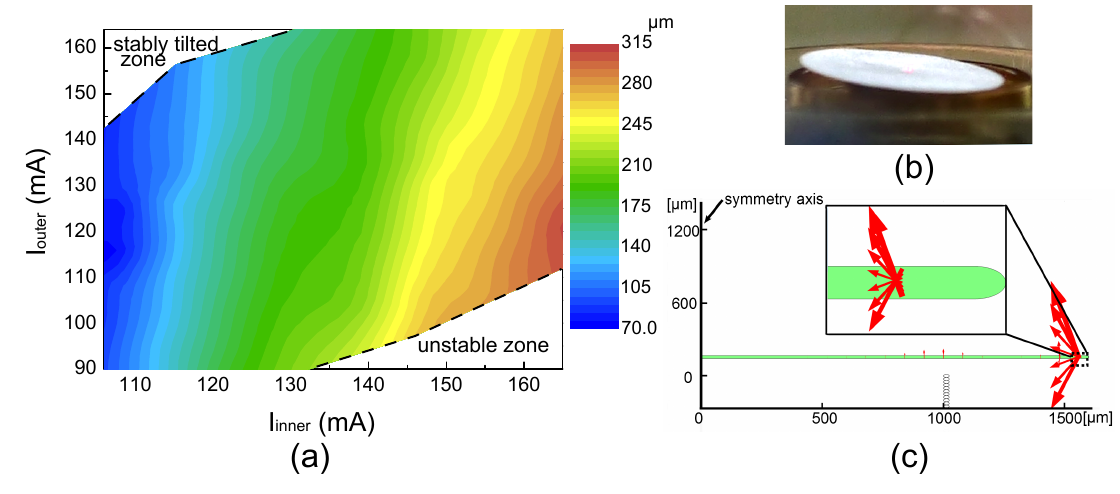
Figure 5. ( a ) Levitation height as a function of RMS values of input currents. ( b ) Photo of a tilted PM. ( c ) Lorentz force distribution (red arrow) under the condition of I 2 I = 220 mA inner